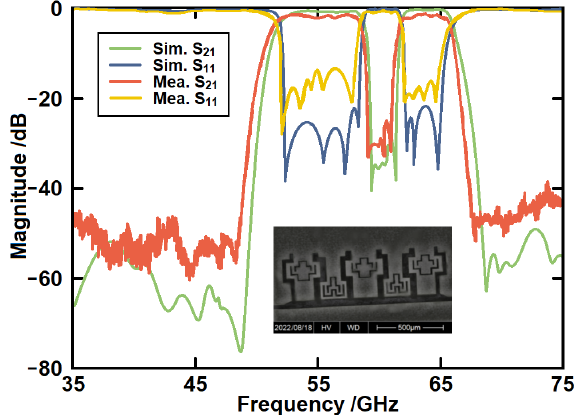
Figure 19. The simulated and measured results of the proposed filter.